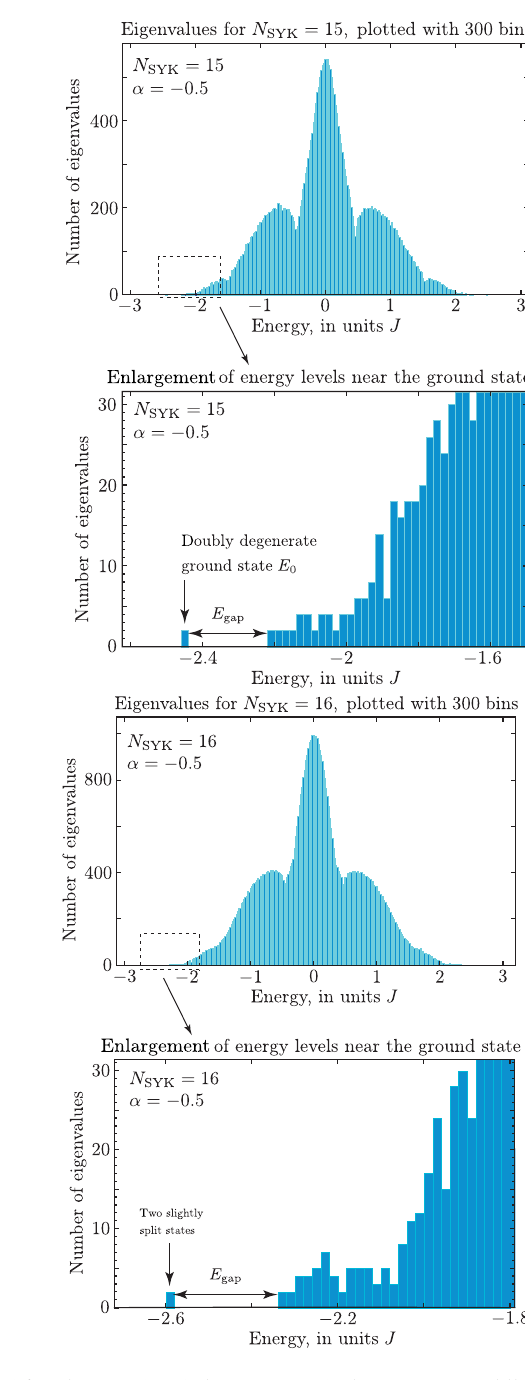
FIG. 18. The spectrum for a single realization with N E ¼ 0 when N is odd and a large number of states with E ¼ 0 SYK